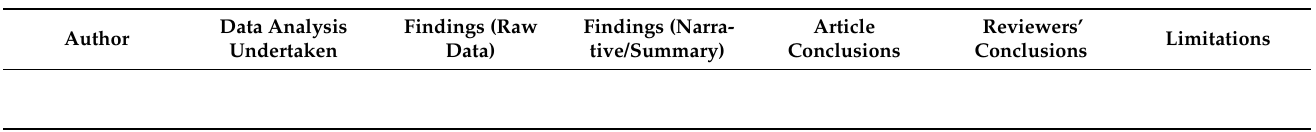
Table A3. Summary of the results of included